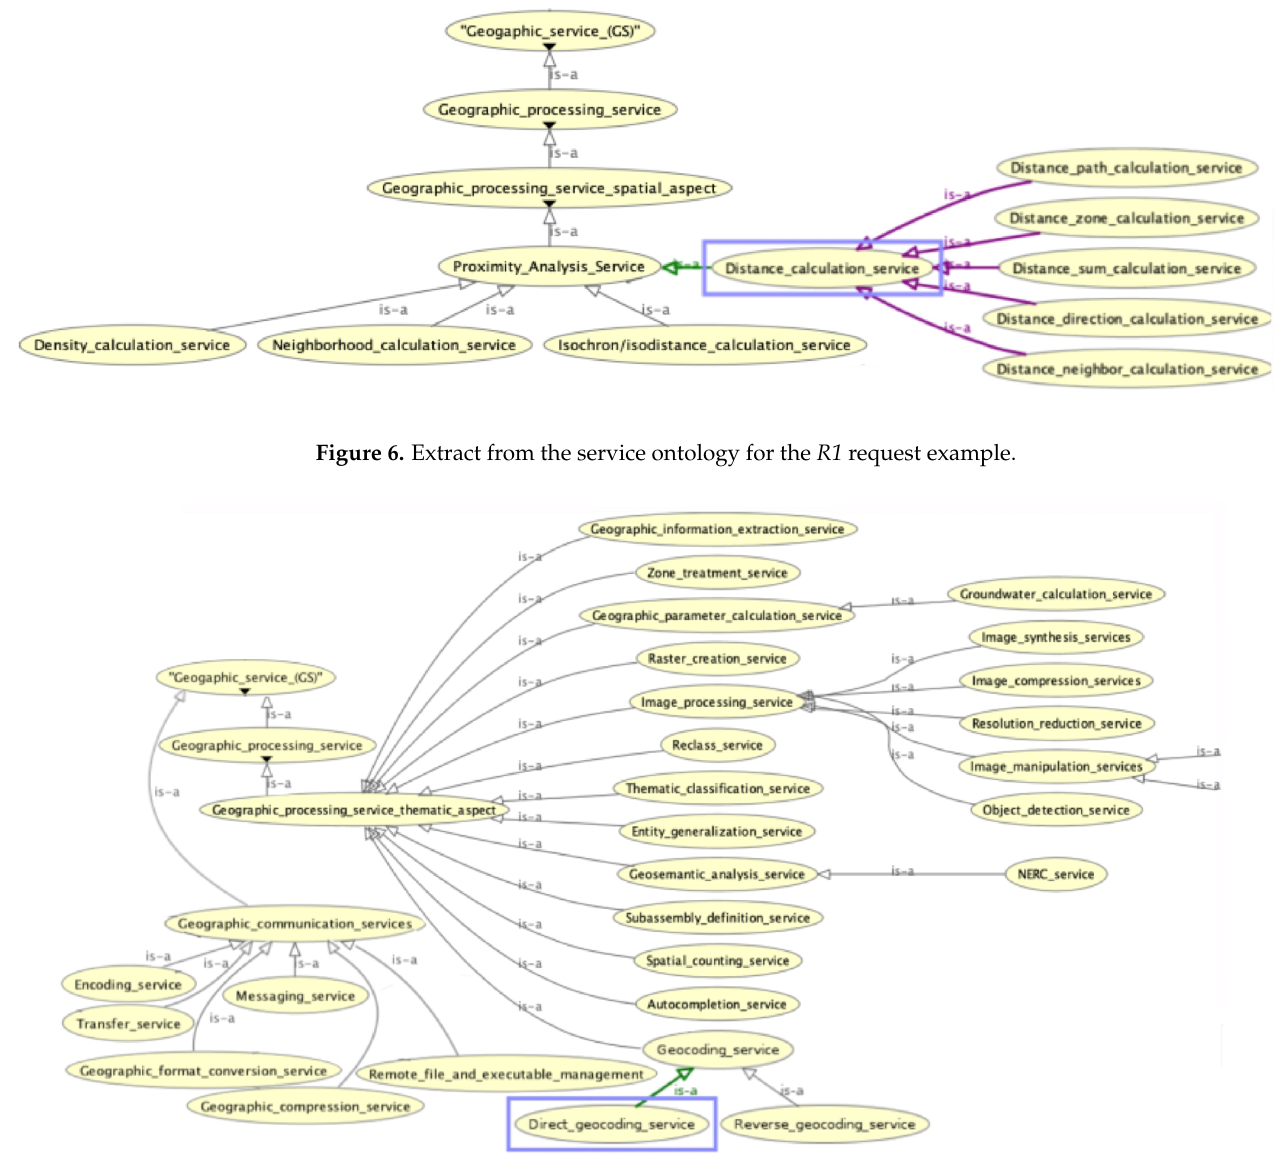
Figure 6. Extract from the service ontology for the R1 request example.